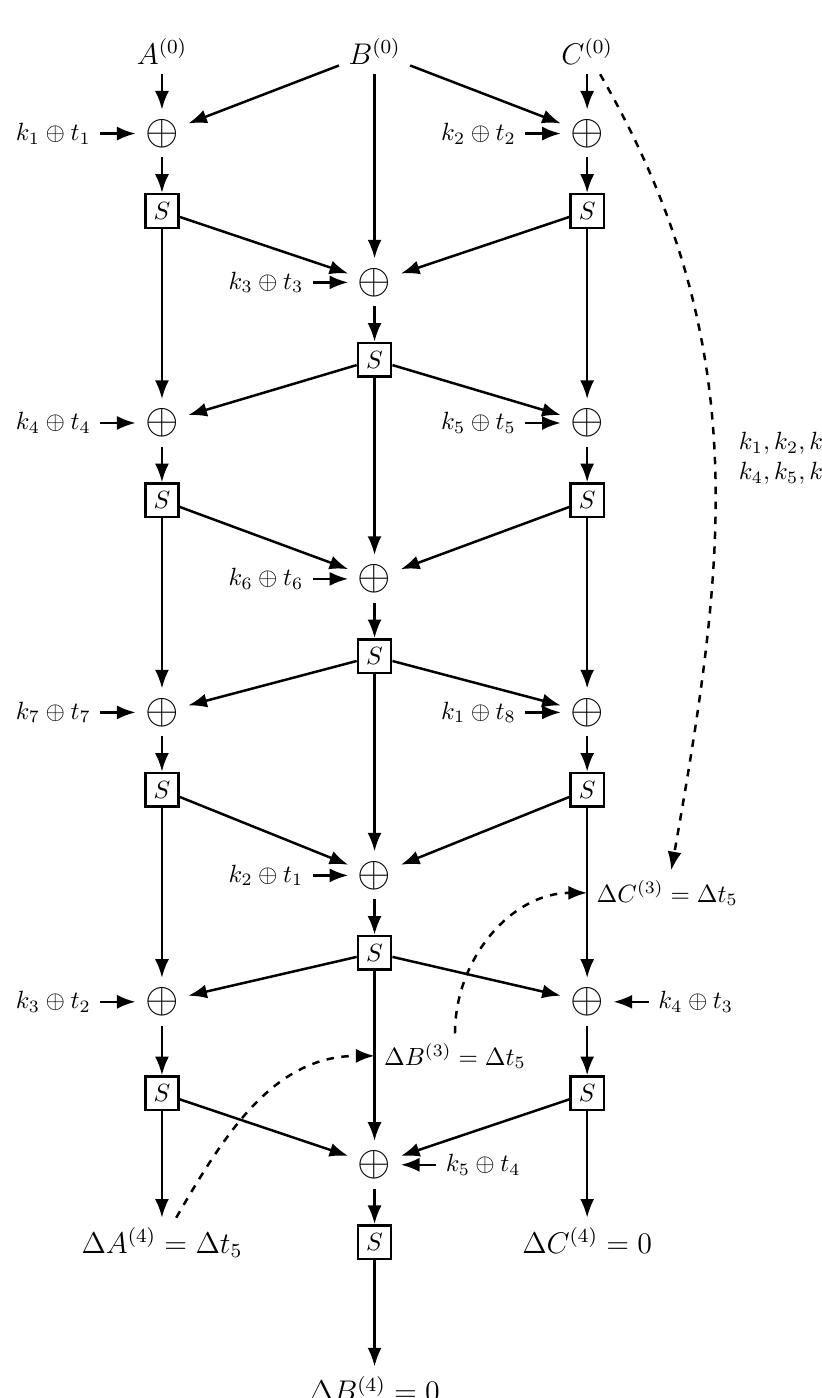
Figure 2: The first four rounds in the attacks on